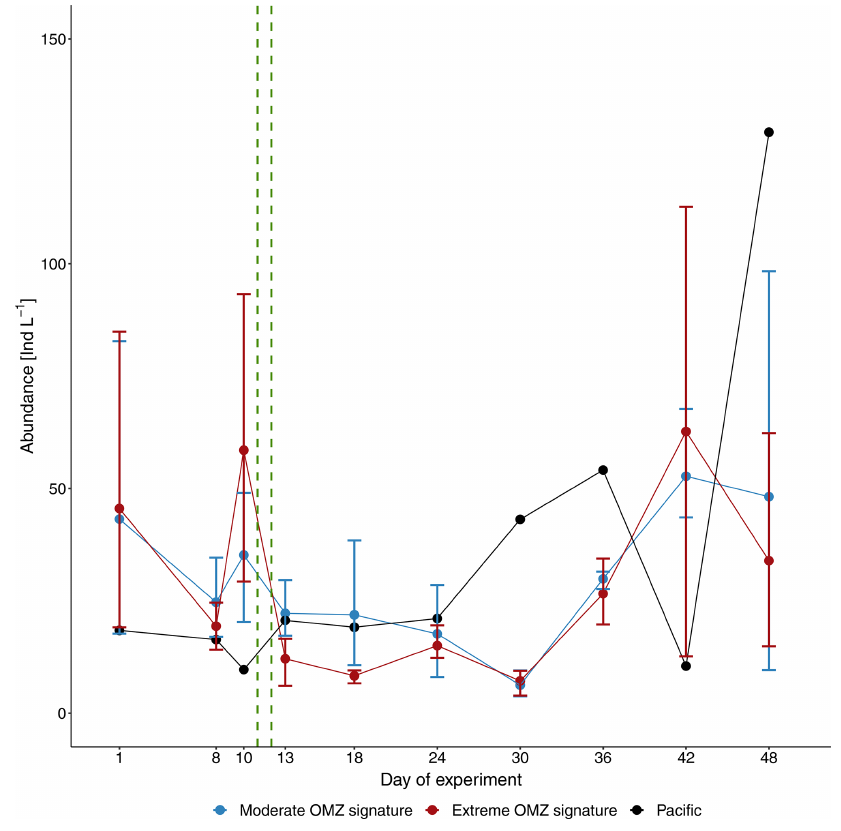
Figure 3. Average total abundance of mesozooplankton (individuals per liter, IndL − 1 ) in the mesocosms with moderate and extreme OMZ signatures and the adjacent Pacific station. Error bars depict 95% confidence intervals. The green vertical dashed lines indicate the days of OMZ water